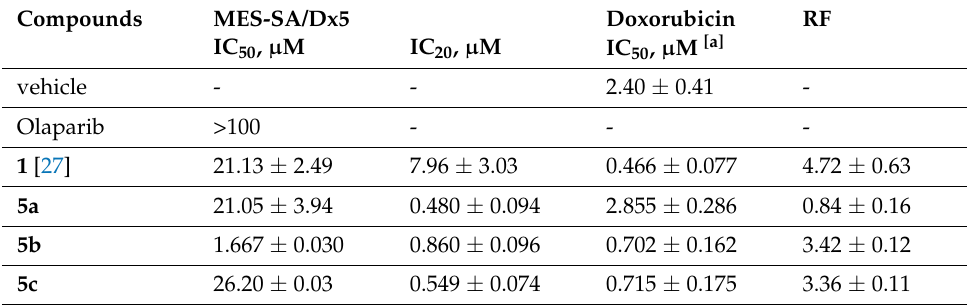
Table 2. Cytotoxicity of 5a – c on the MES-SA/Dx-5 cell line. Compounds MES-SA/Dx5 Doxorubicin RF IC 50 , µ M IC 20 , µ M IC 50 , µ M [a] vehicle - - 2.40 ± 0.41 - Olaparib >100 - - - 1